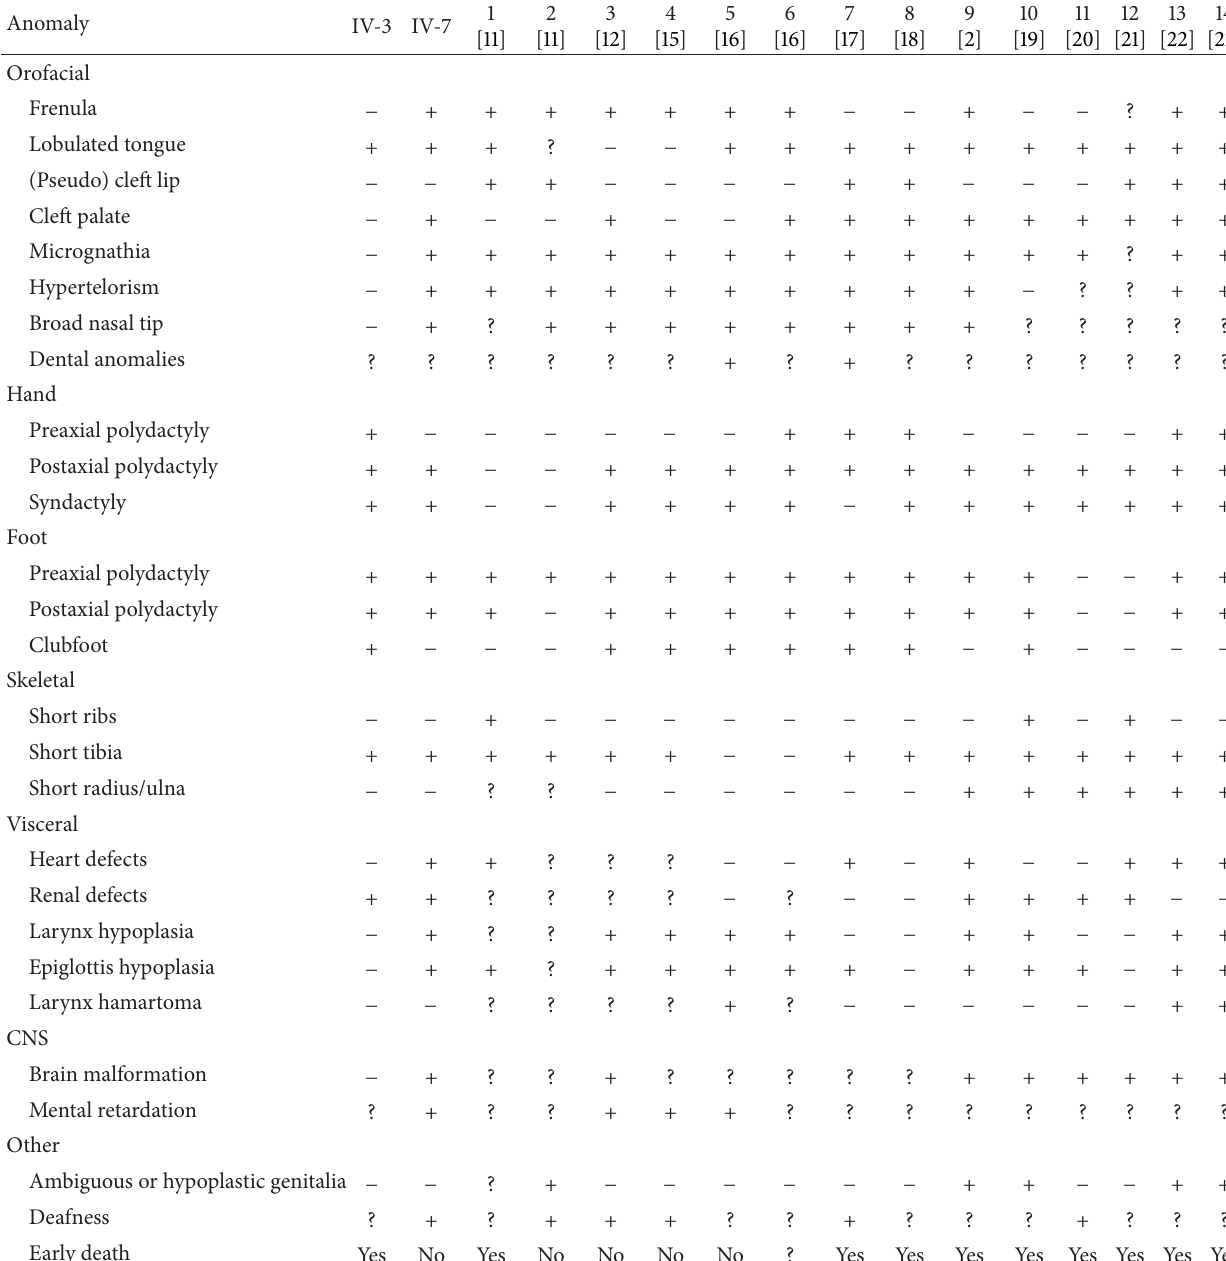
Table 1: Clinical features of current family and patients reported in the